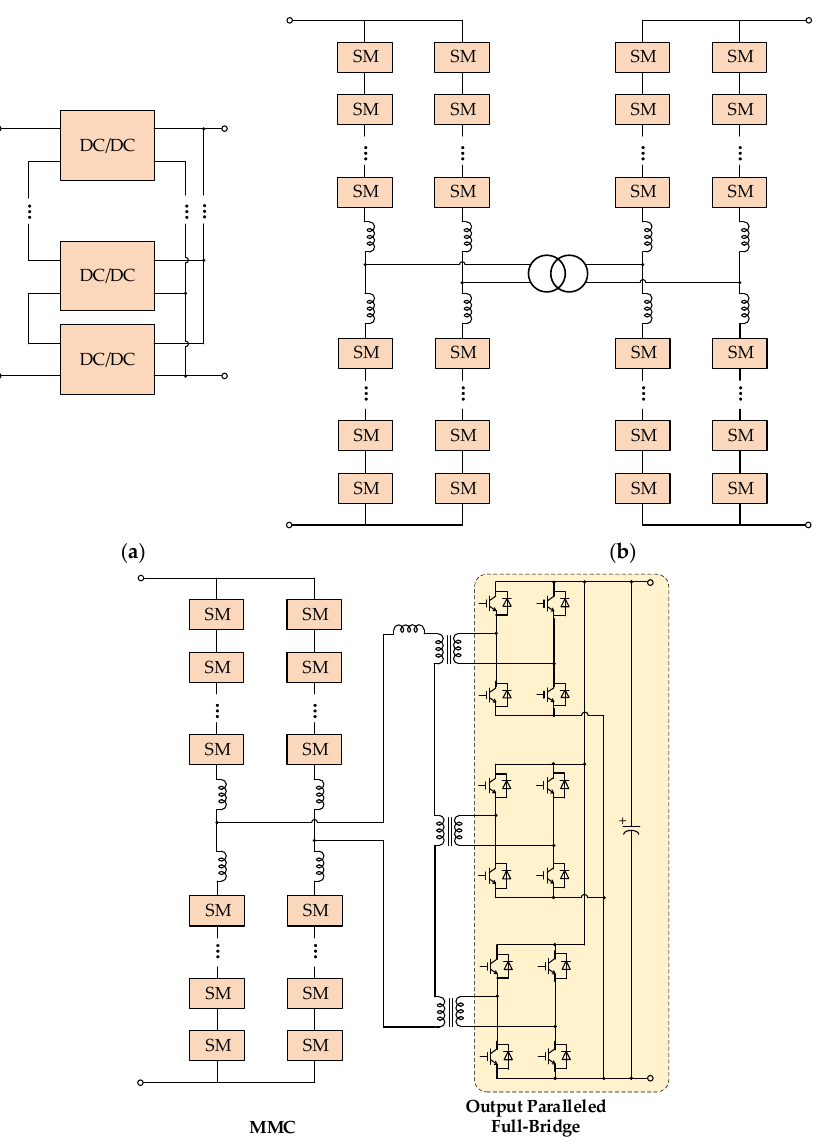
Figure 2. Typical topologies of DCTs: ( a ) ISOP, ( b ) F2F-MMC, and ( c ) MMFB.